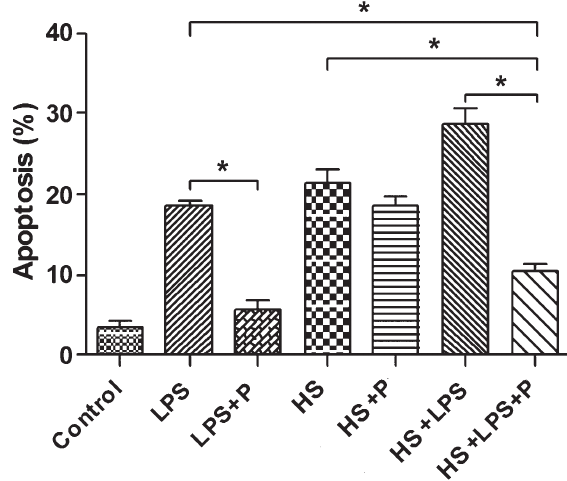
Figure 4. Effect of propofol (P) on the apoptosis ratio of IEC-6 after heat stress (HS), lipopolysaccharide (LPS), or a combina- tion of HS and LPS treatment. Double staining with annexin V- fluorescein isothyocyanate and propidium iodide was used to detect the effect of P on the apoptosis ratio of IEC-6. Data are reported as means±SD, n=6. *P , 0.05, Dunnett T3